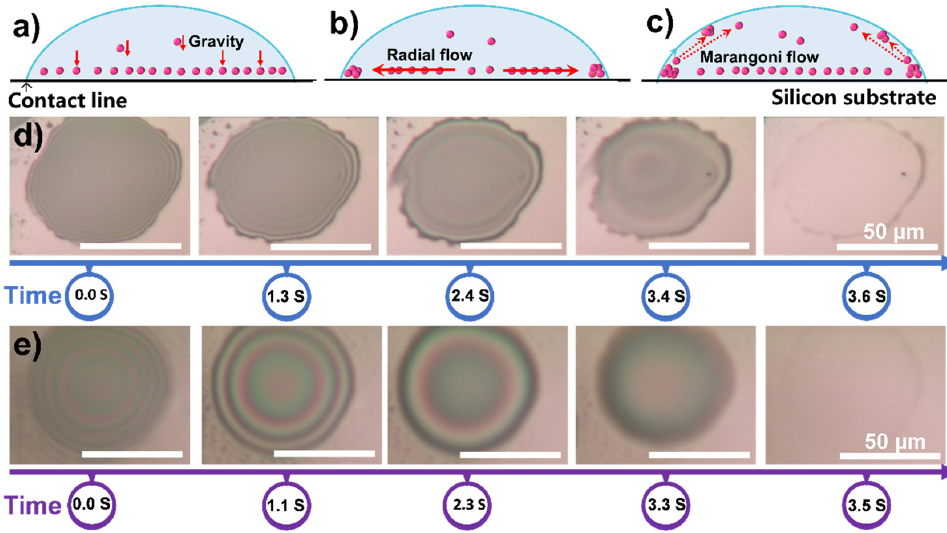
Figure 3. Three main flow patterns of nanoparticles in evaporated droplets of ( a ) downward flow caused by gravity, ( b ) radial flow caused by a maximum evaporation rate at the pinned wetting line and ( c ) Marangoni flow induced by surface tension differences between gas and the liquid interface. Optical microscope images of droplet drying process of ( d ) SiO 2 (0.05) and ( e ) SiO 2 /PVP (0.05/0.01) at different times.